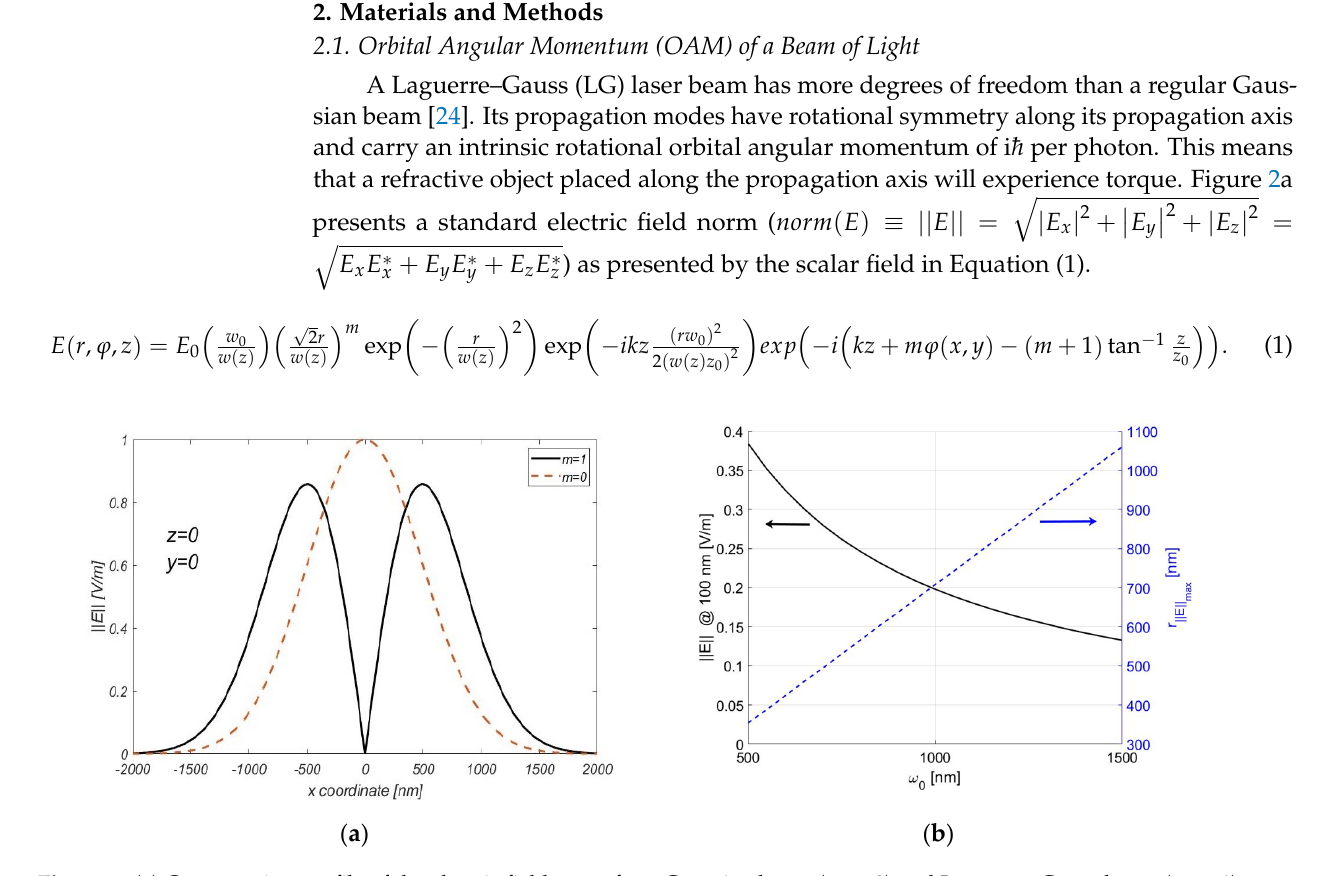
Figure 2. ( a ) Cross-section profile of the electric field norm for a Gaussian beam ( m = 0) and Laguerre–Gauss beam ( m = 1). Both beams have ω 0 = 700 nm. ( b ) Electric field norm at r = 100 nm, near the center of the antenna and spatial location of the maximum beam intensity. Both numbers are a function of the beam radius at the focal